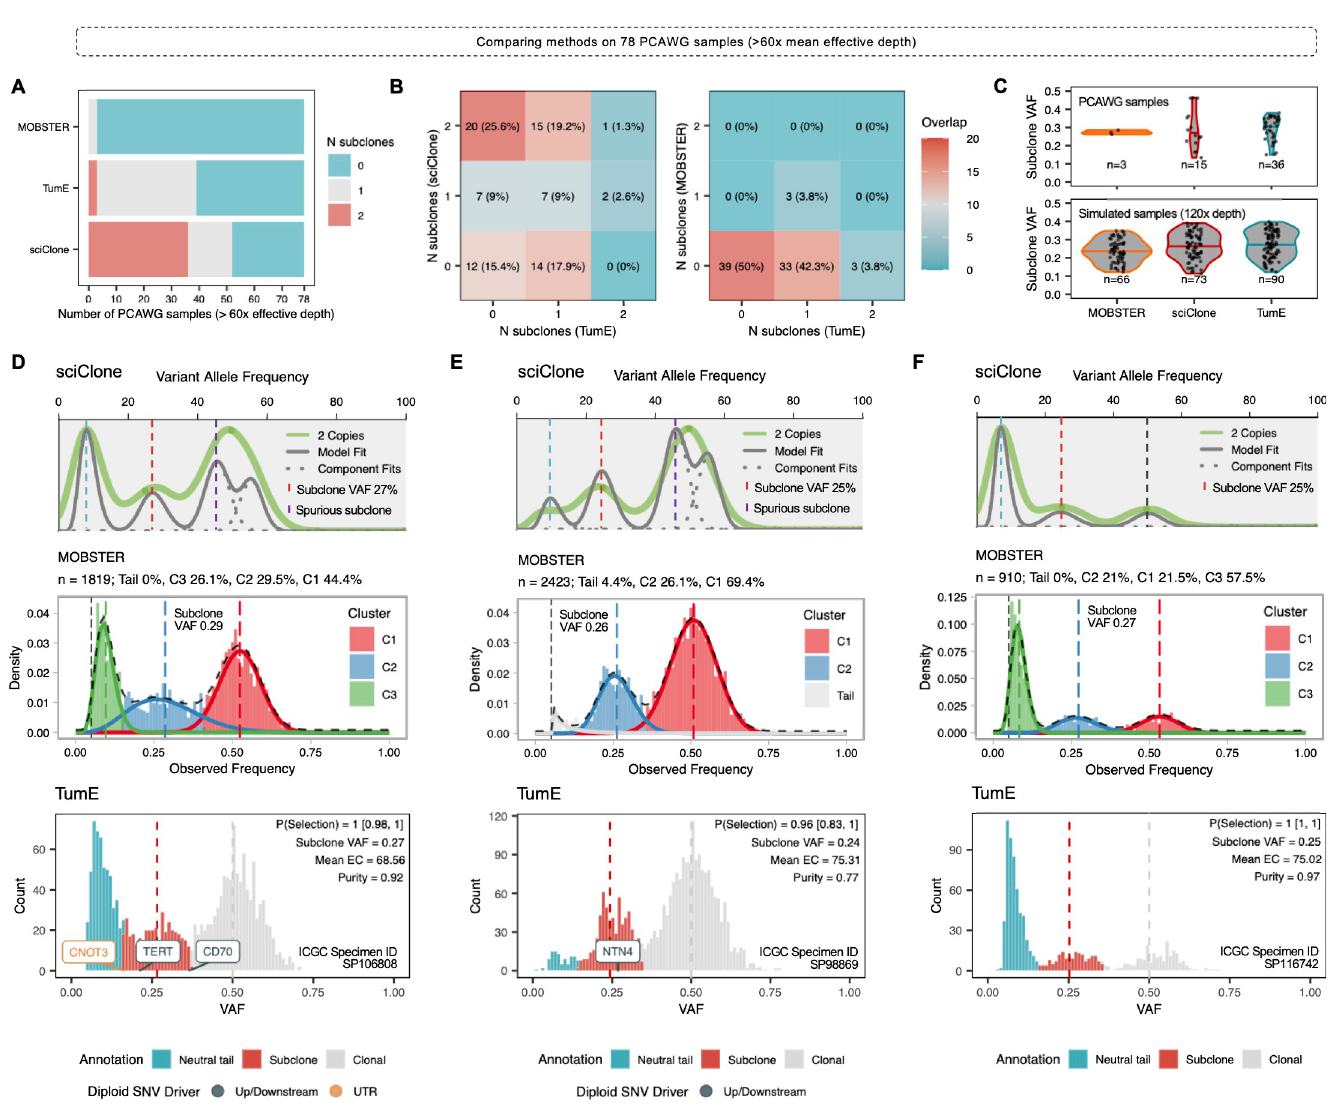
Fig 4. Comparison of subclone detection methods in 78 PCAWG samples with mean effective sequencing depth (purity � depth) of greater than 60x. (A) Number of subclone estimates using different methods including MOBSTER [16], sciClone [24], and TumE. (B) Comparing agreement and disagreement between existing methods in the analyzed PCAWG samples. (C) Comparison of the estimated subclone frequency in PCAWG samples versus simulated data across different methods. Consistent with simulated data where each method properly identified the presence of 1 subclone, TumE consistently captures higher frequency subclones when compared to MOBSTER. (D–F) Visualization of the 3 samples where each TumE and MOBSTER detected 1 subclone. sciClone fits are provided for comparison. Single-nucleotide variants (SNV) with annotations in known driver genes [8,16] were labeled if present.